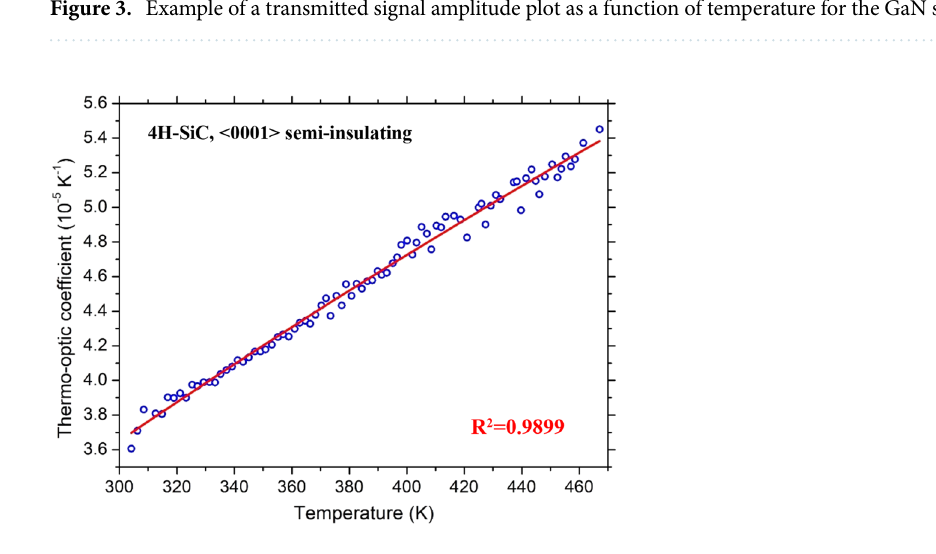
Figure 4. Thermo-optic coefficient as a function of temperature for the 4H-SiC